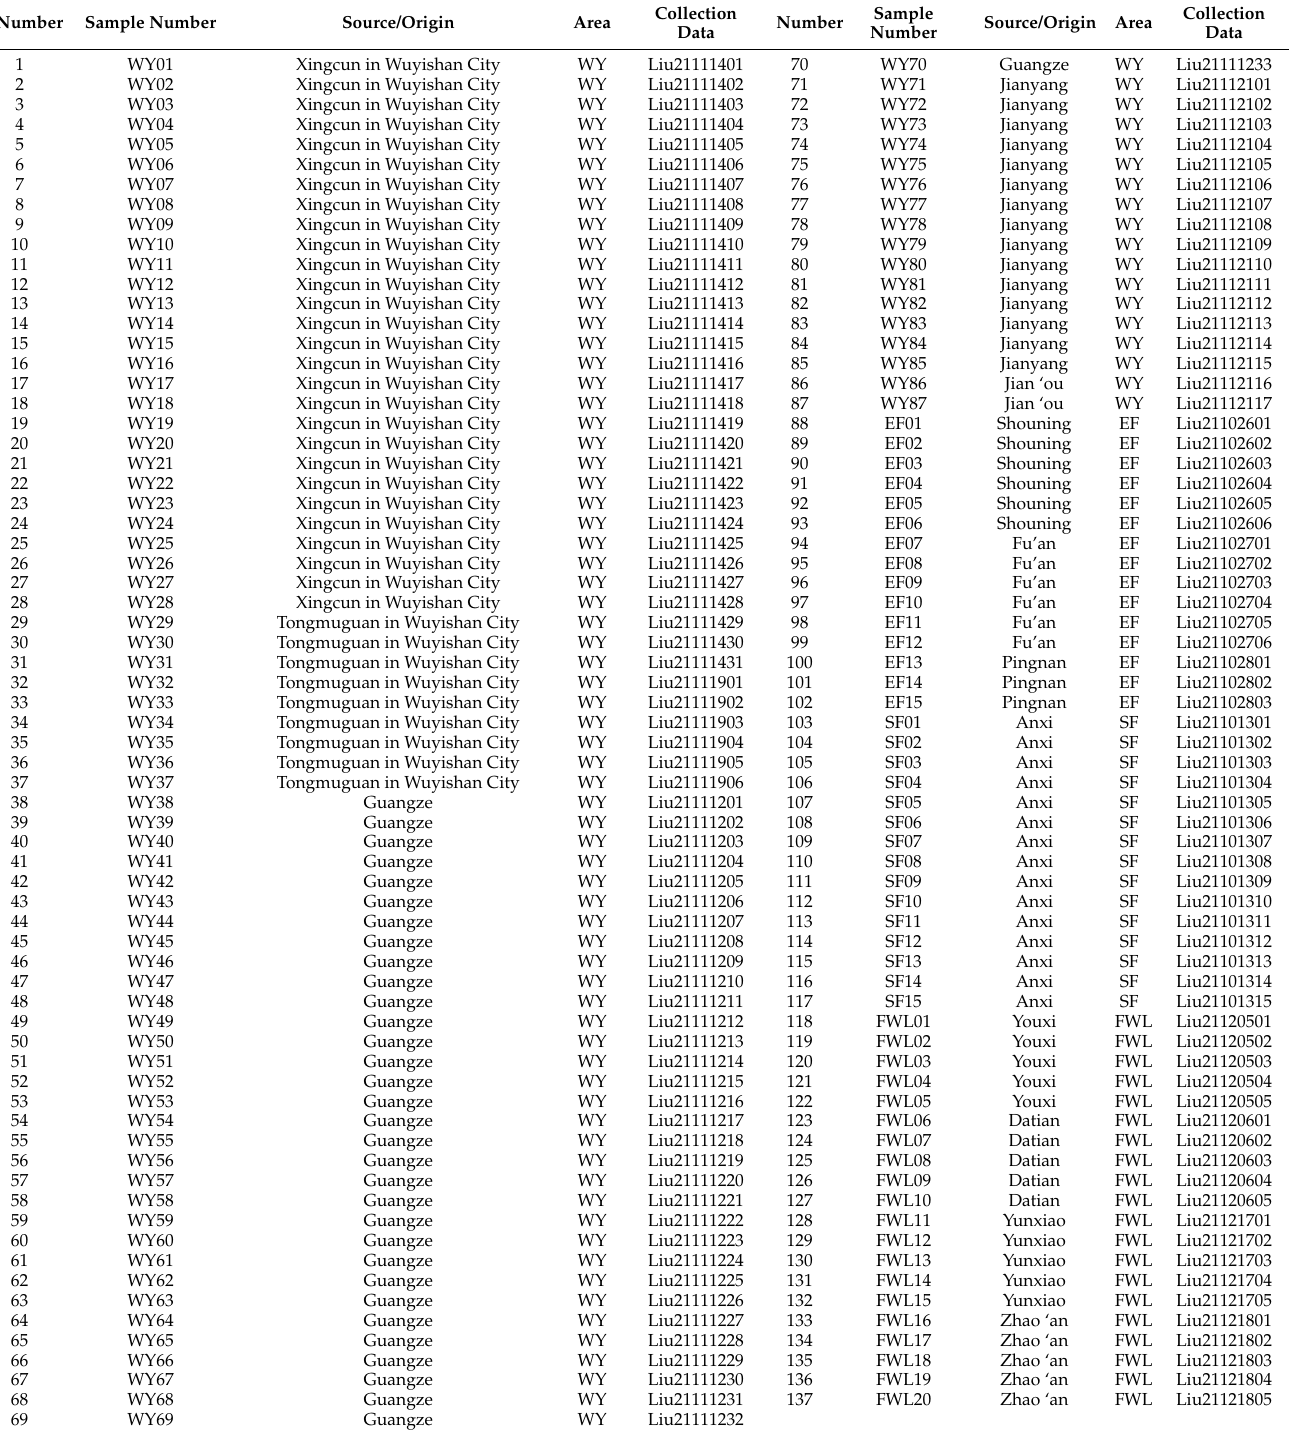
Table 1. List of 137 tea samples used in SNP